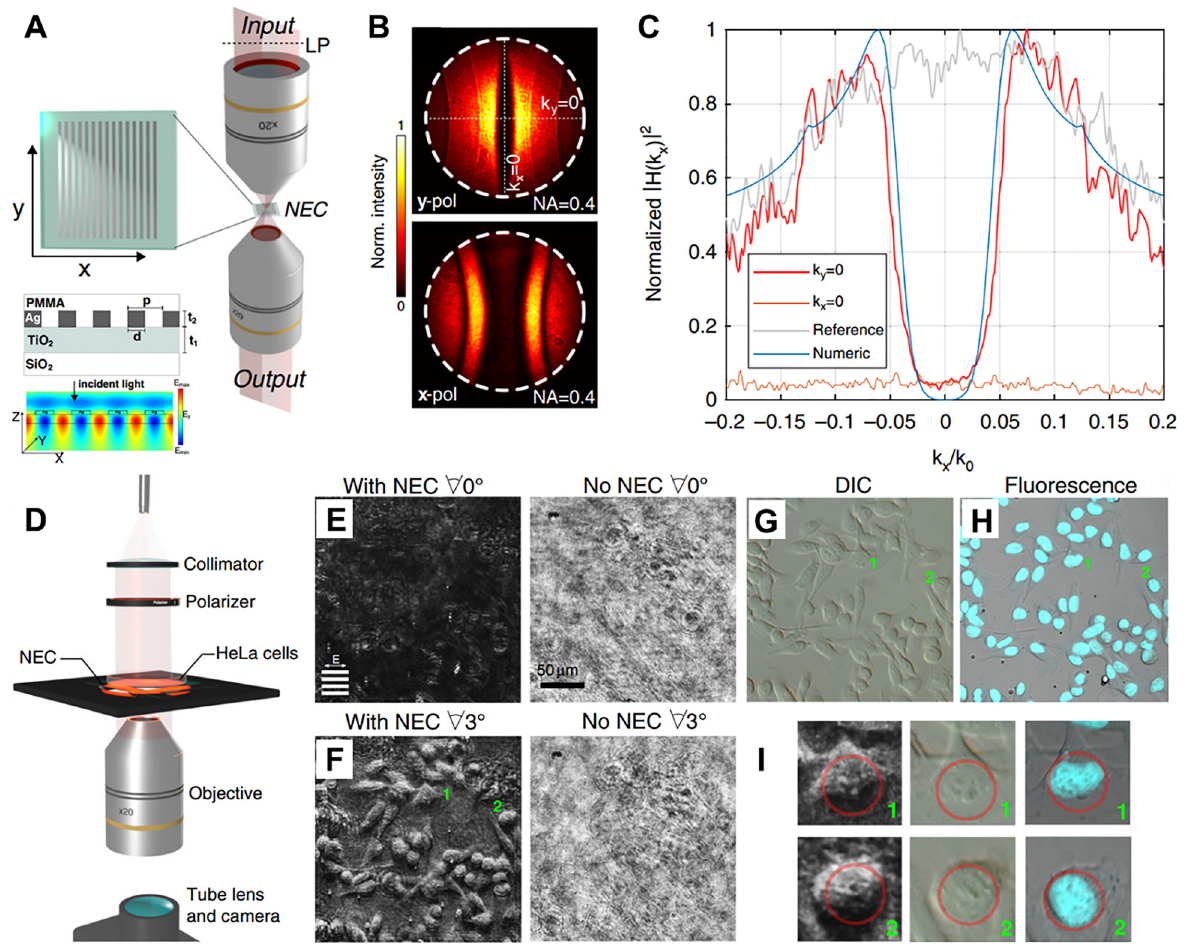
Figure 10: Nanophotonics enhanced coverslip (NEC) for high-contrast intensity images of phase objects [126]. (A) Measuring equipment for optical transferfunction of fabricatedNEC. The linear polarizer selectsthe desired polarization direction relative to direction of the grating fringes on the NEC (inset marked by dotted line). The output lens produces a Fourier plane image. The other inset reveals the nanostructure of NEC cross-section, in which design parameters are t 1 = 100 nm, t 2 = 40 m, d = 200 nm, and p = 400 nm. When thelightofwavelength λ = 650nmisincidentvertically,thesimulatedelectric fi elddistribution( ̂ y component)oftheinducedstandingwavein the waveguide is displayed. (B) The normalized two-dimensional modulation transfer function measured when the incident light (wavelength of λ = 637nm)ispolarizedparallelto( y -pol)andperpendiculartothesilvergratingfringe( x -pol).(C)Thecross-sectionalviewalongthedotted line (red) in (B), which highlights the suppression of low k in the direct beam. The corresponding simulated pro fi le of the s -polarization (blue) and the spatial frequency of the incident beam (grey) are given for comparison with experimental measurements. (D) Experimental device for phase object microscopy imaging: The wavelength of the light source is 637 nm, and the incident light fi eld whose polarization direction is parallel to the grating line is generated through the collimator and polarizer. The culture dish of Human cancer cells (HeLa) is fi xed on top of NEC. (E) – (F) Images obtained with the same cell area with and without NEC under two different tilts (no tilt in (E), tilt 3 ° in (F)) relative to the incident light. (G) – (H) A conventional microscope image of the same cell using DIC and fl uorescence. The blue area in the fl uorescence image highlightsthecellnucleus.(I)Themagni fi edimageshownbythenumberin(F)to(H)forNECtiltedat3 ° ,DICand fl uorescencemicroscope.The circle highlights the nucleolus in each cell